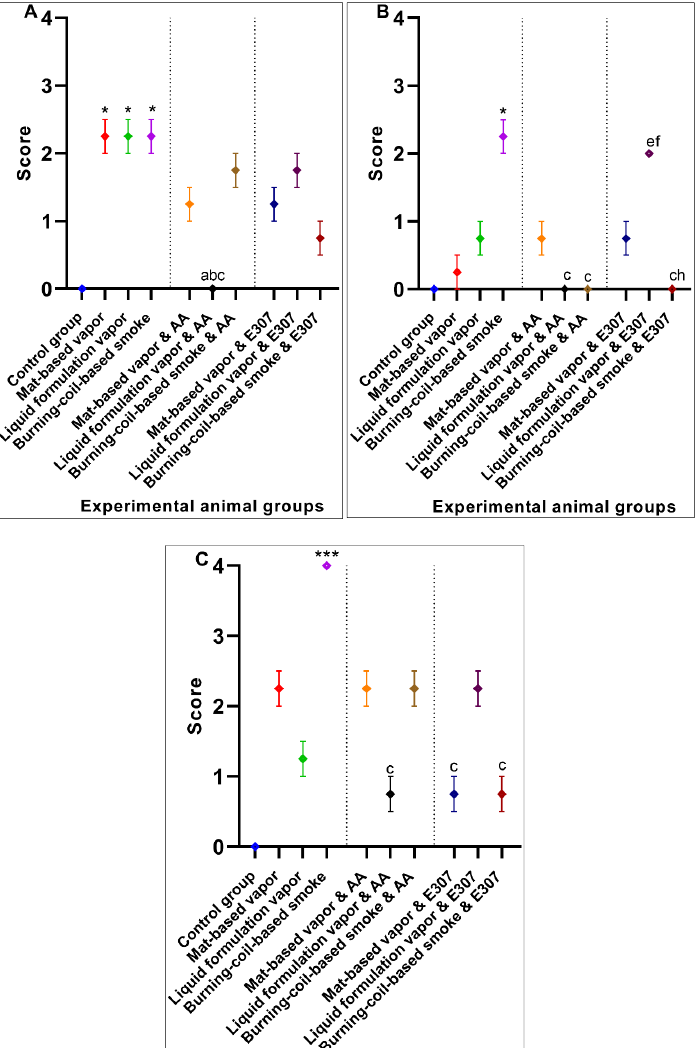
Figure 5. Effects of ascorbic acid (AA) and α -tocopherol (E307) on the pyrethroid-induced toxicity in Figure 5. E ff ects of ascorbic acid (AA) and α -tocopherol (E307) on the pyrethroid-induced the animals’ hearts showing atrophy ( A ), congestion of blood vessels ( B ), and hyperemia ( C ). Values